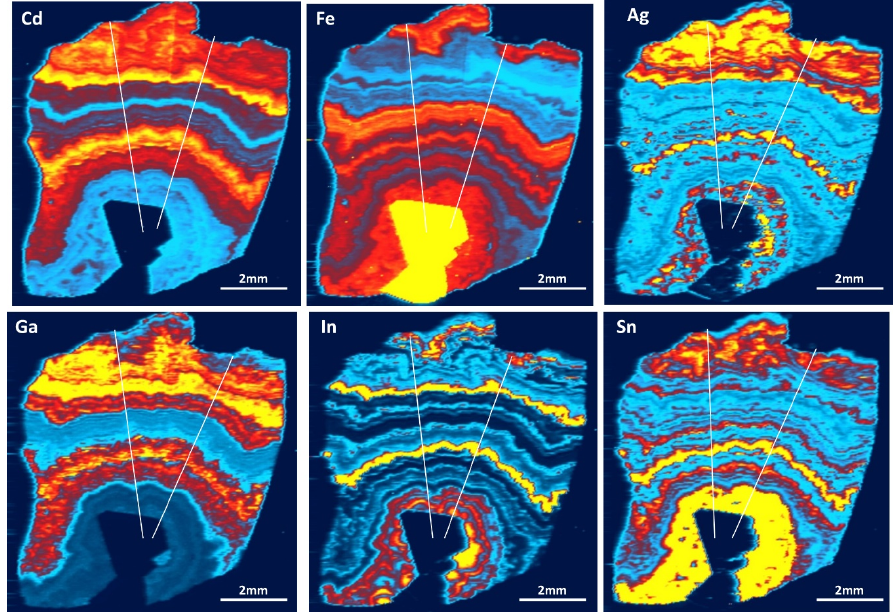
Figure 3. LA-ICP-MS element maps for Cd, Fe, Ag, Ga, In and Sn from a cross-section of the wurtzite–sphalerite intergrowth (SAM G33739). The coloring is based on relative concentrations on a linear scale, with red being highest, yellow intermediate concentrations, and blue lowest, clearly showing trace element variation with growth zoning. The positions of the line scan 1 (right-hand line) and line scan 2 (left-hand line) scans are indicated by the white